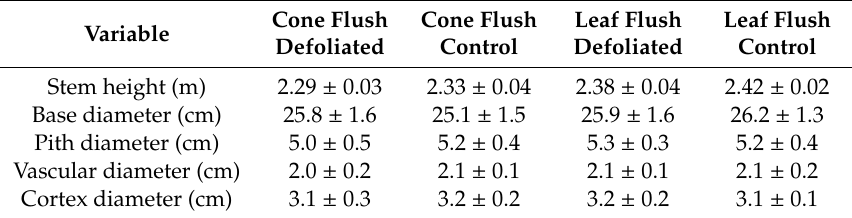
Table 1. Experimental details for studying stem carbohydrate relations of Cycas micronesica trees. during male cone or leaf growth. Mean ± standard error, n =